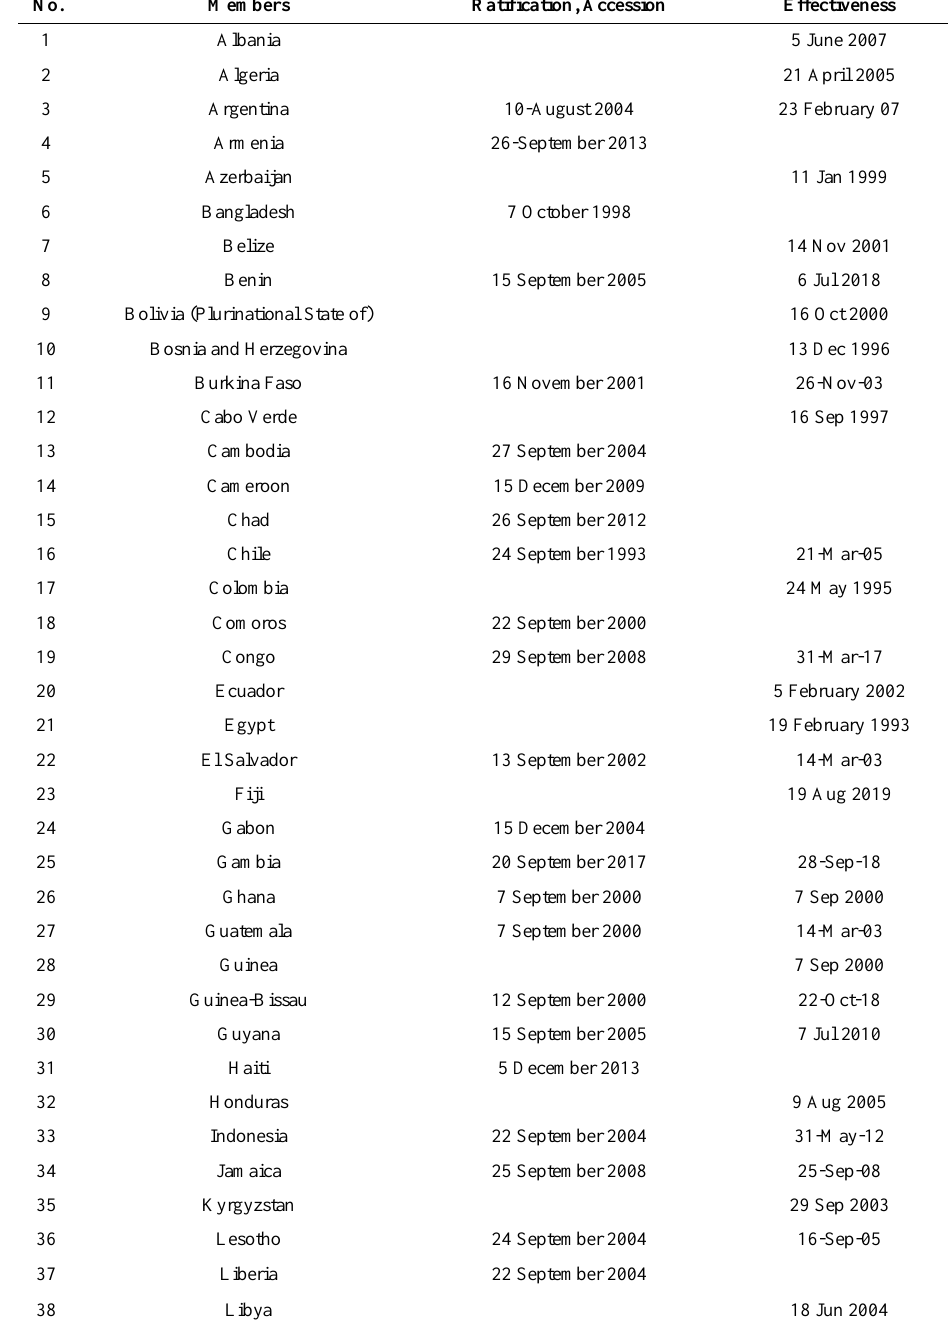
Table 2. List of the current participants that open for signature by all States in accordance with its Article